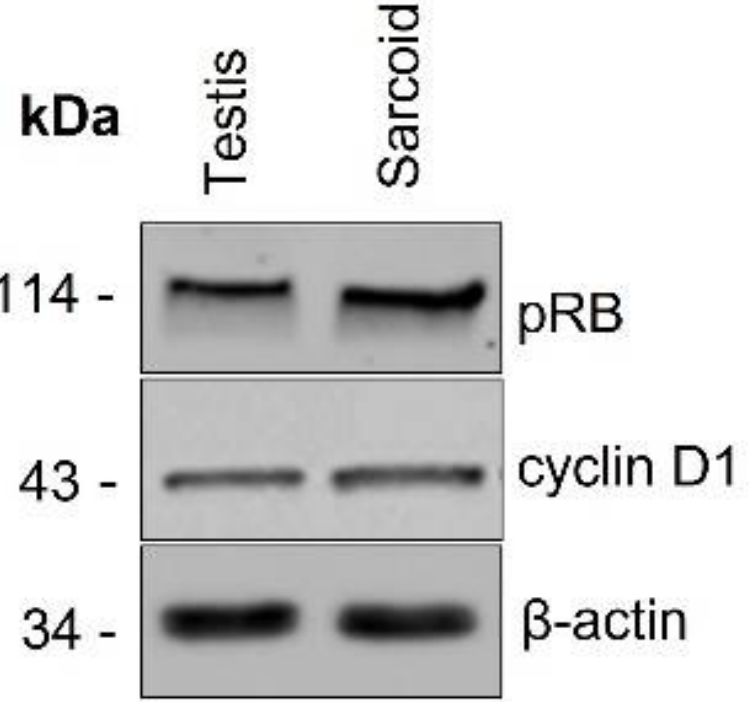
Figure 1. Western blot. Western Blot analysis shows 43 KDa and 114 KDa bands in both normal equine testis and sarcoid, corresponding to Cyclin D1 and pRb protein, respectively. Beta-actin was used as control.